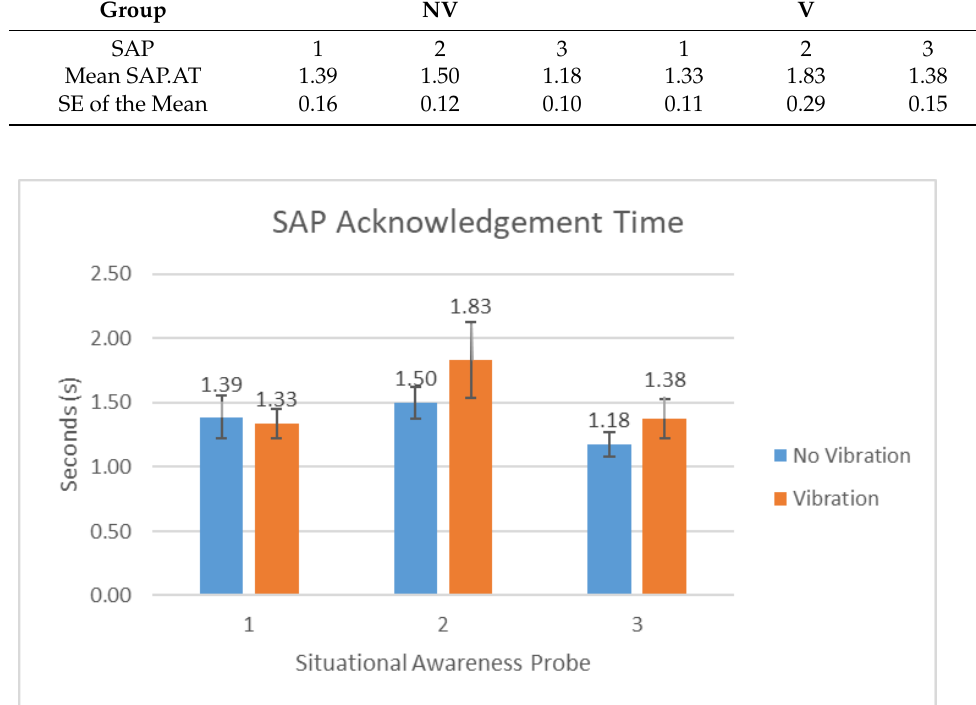
Figure 7. Situation awareness probe acknowledgement time (SAP.AT) to the three situation awareness probes (SAPs) for each participant group, “No Vibration” (NV) and “Vibration” (V). Bars provide mean values with error bars representing standard error of the mean.